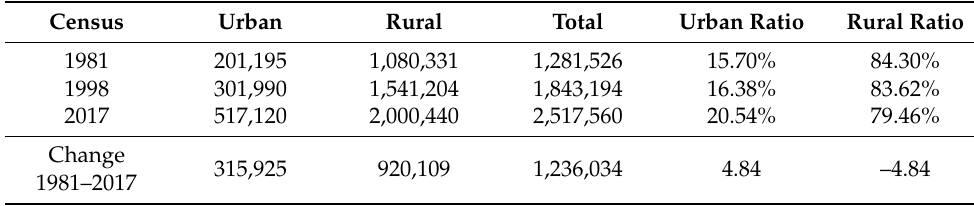
Table 6. Census of Sahiwal District from 1981 to